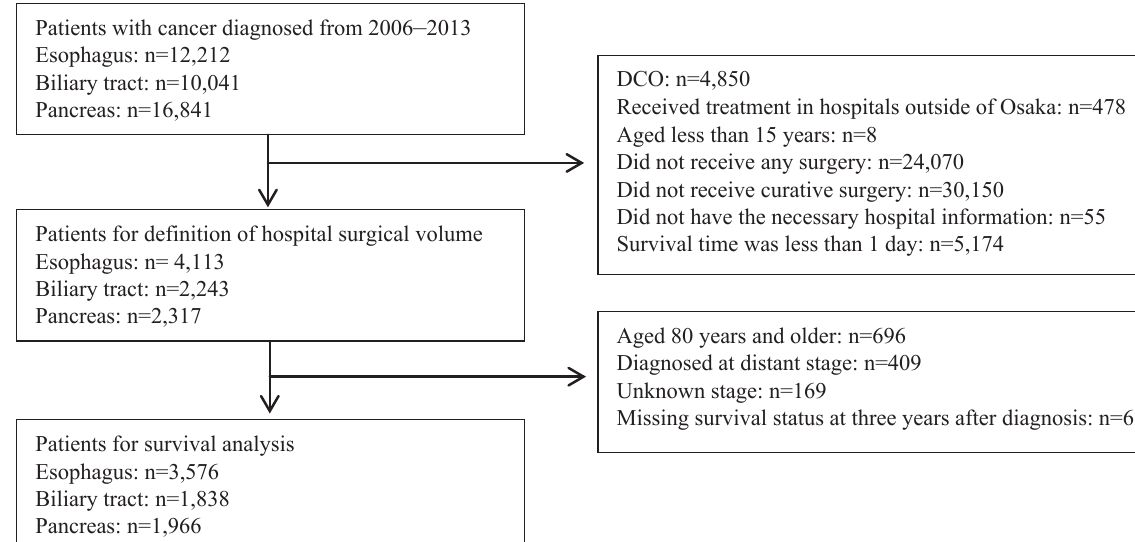
Figure 1. Flow chart for selection of patients in the Osaka Cancer Registry. DCO, death certi fi cation